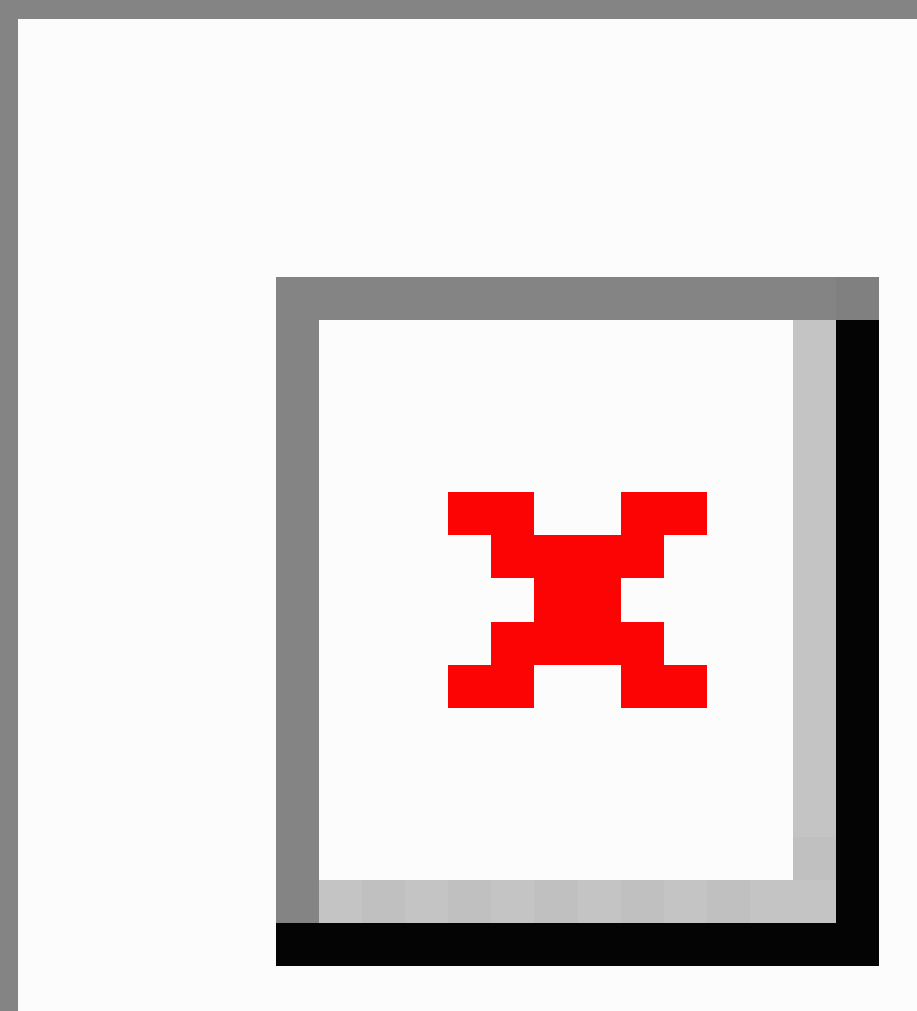
Figure 2. Evidence-informed design components of Crush the Crave